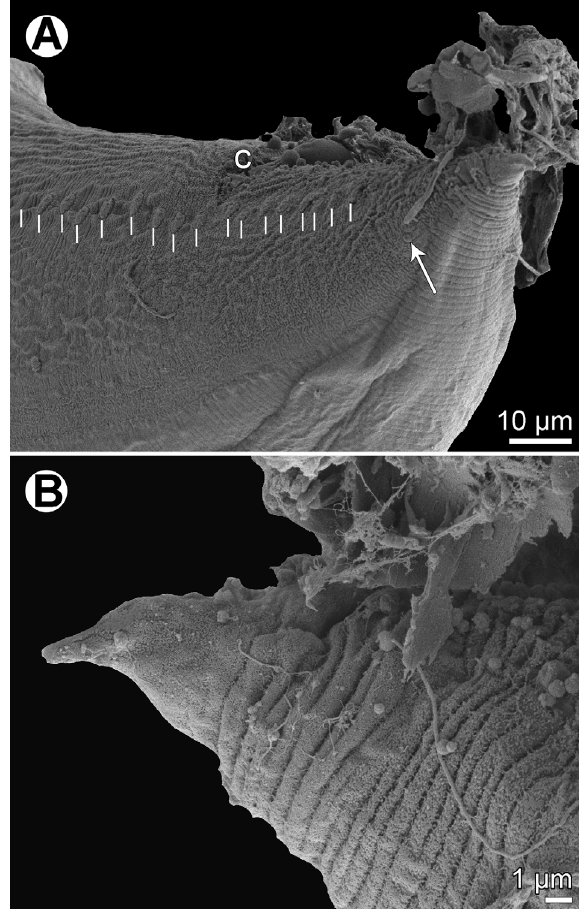
Figure 8. Raphidascaris ( Ichthyascaris ) nudicauda n. sp. , scanning electron micrographs of male. (A) Tail, lateral view (white bars designate caudal papillae; arrow indicates phasmid); (B) tail tip, lateral